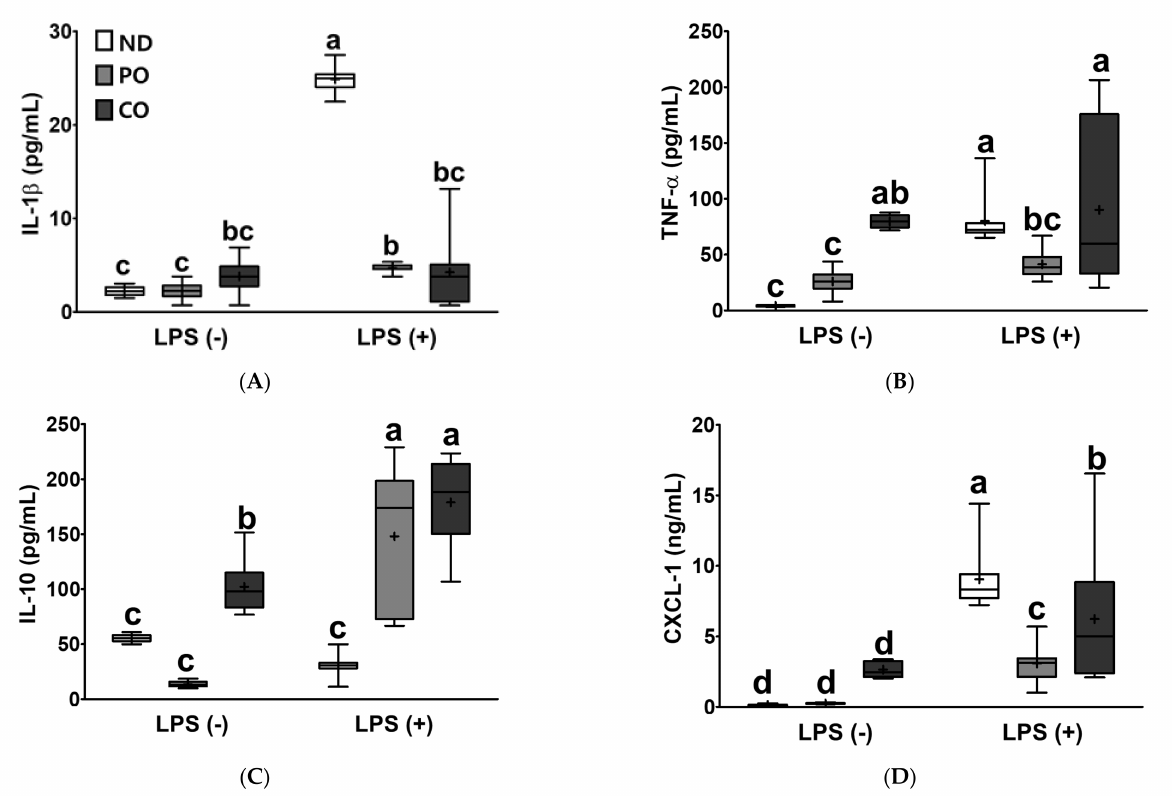
Figure 5. Partial replacement of dietary fat with PO or CO and LPS challenge on the pro/anti- inflammatory cytokines, chemokine in serum. Mice were fed either an ND or an ND partially replaced with PO or CO for 12 weeks and then treated with PBS or LPS (1 mg/kg) for 24 h ( n = 8 per group). ( A ) Interleukin (IL)-1 β levels; ( B ) tumor necrosis factor (TNF)- α levels; ( C ) IL-10 levels; ( D ) C-X- C Motif Chemokine Ligand 1 (CXCL-1) levels. Values are presented as box and whisker plots representing 8 mice per group. Data were analyzed using two-way ANOVA followed by Tukey’s post hoc test (LPS × Diet interaction). Labeled means without a common letter differ ( p <